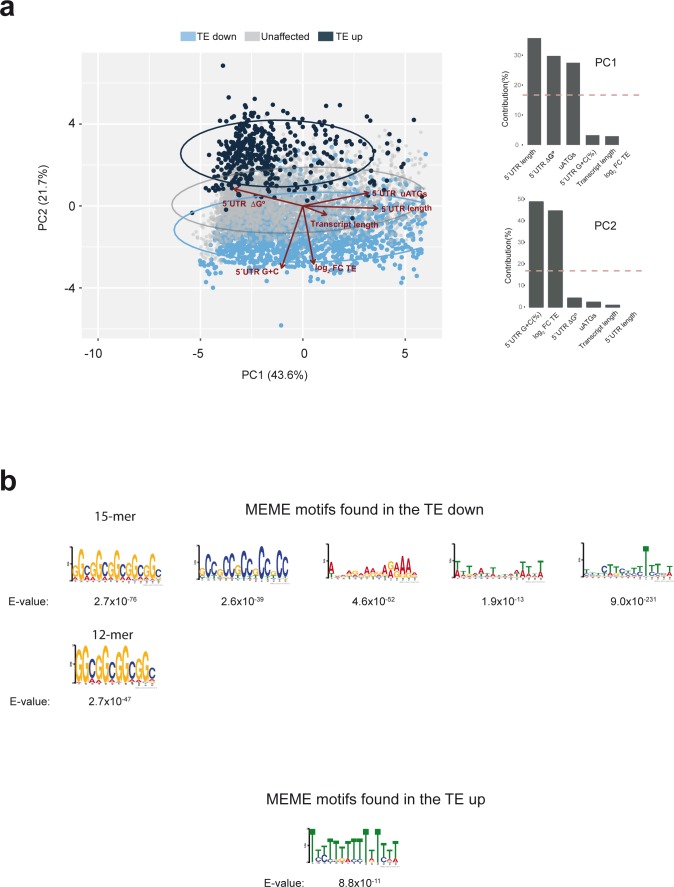
Further bioinformatic analysis of the data from experiment shown in Figure 5.(a) Principal component analysis (PCA) of human mRNAs detected in our dataset using features describing transcript length, 5′ UTR length, 5′ UTR G+C(%), 5′ UTR ΔG°, 5′ UTR uATGs and the calculated log2FC TE. 'TE down', 'TE up' and unaffected mRNAs are in blue, black and gray, respectively. The contributions of the different variables to PC1 and PC2 are indicated. (b) Motifs found in the ‘TE down’ and ‘TE up’ groups of mRNAs using the MEME algorithm. E-values are indicated.